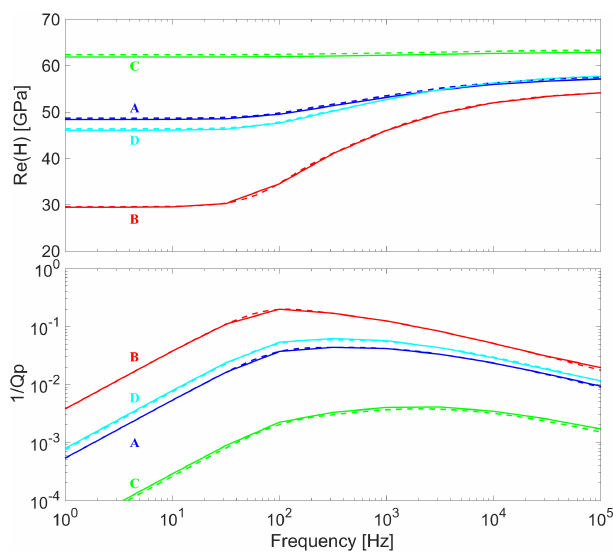
Figure 9. Real part of P-wave modulus ( H ) and attenuation for wave propagation normal to the fractures as functions of frequency. Solid lines correspond to fracture models A, B, C and D from Fig. 5 with variable aperture distributions. Dashed lines correspond to fracture models of constant thickness using equivalent fracture properties (Table